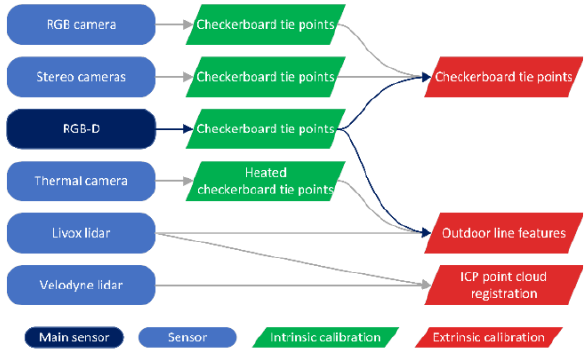
Figure 4: Overview of the calibration procedure: observations linking coordinate frames of different